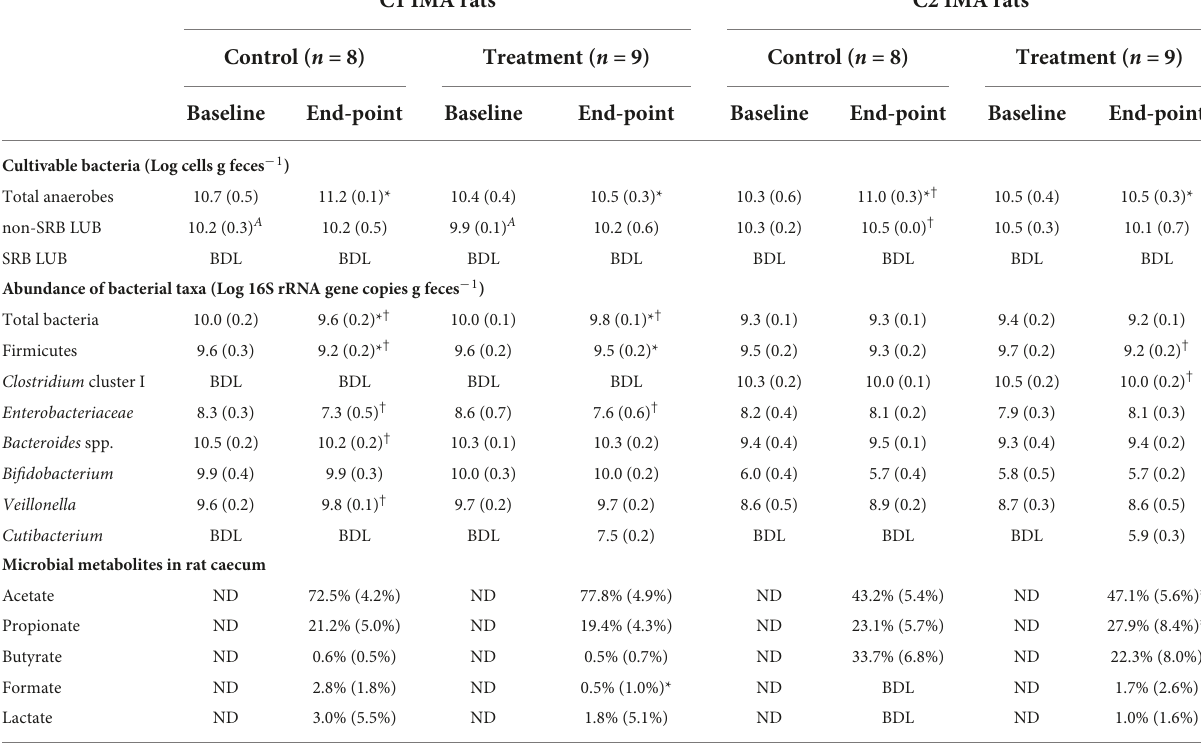
TABLE 2 Main bacterial communities in feces from colic IMA rats at baseline and after intervention. C1 IMA rats C2 IMA